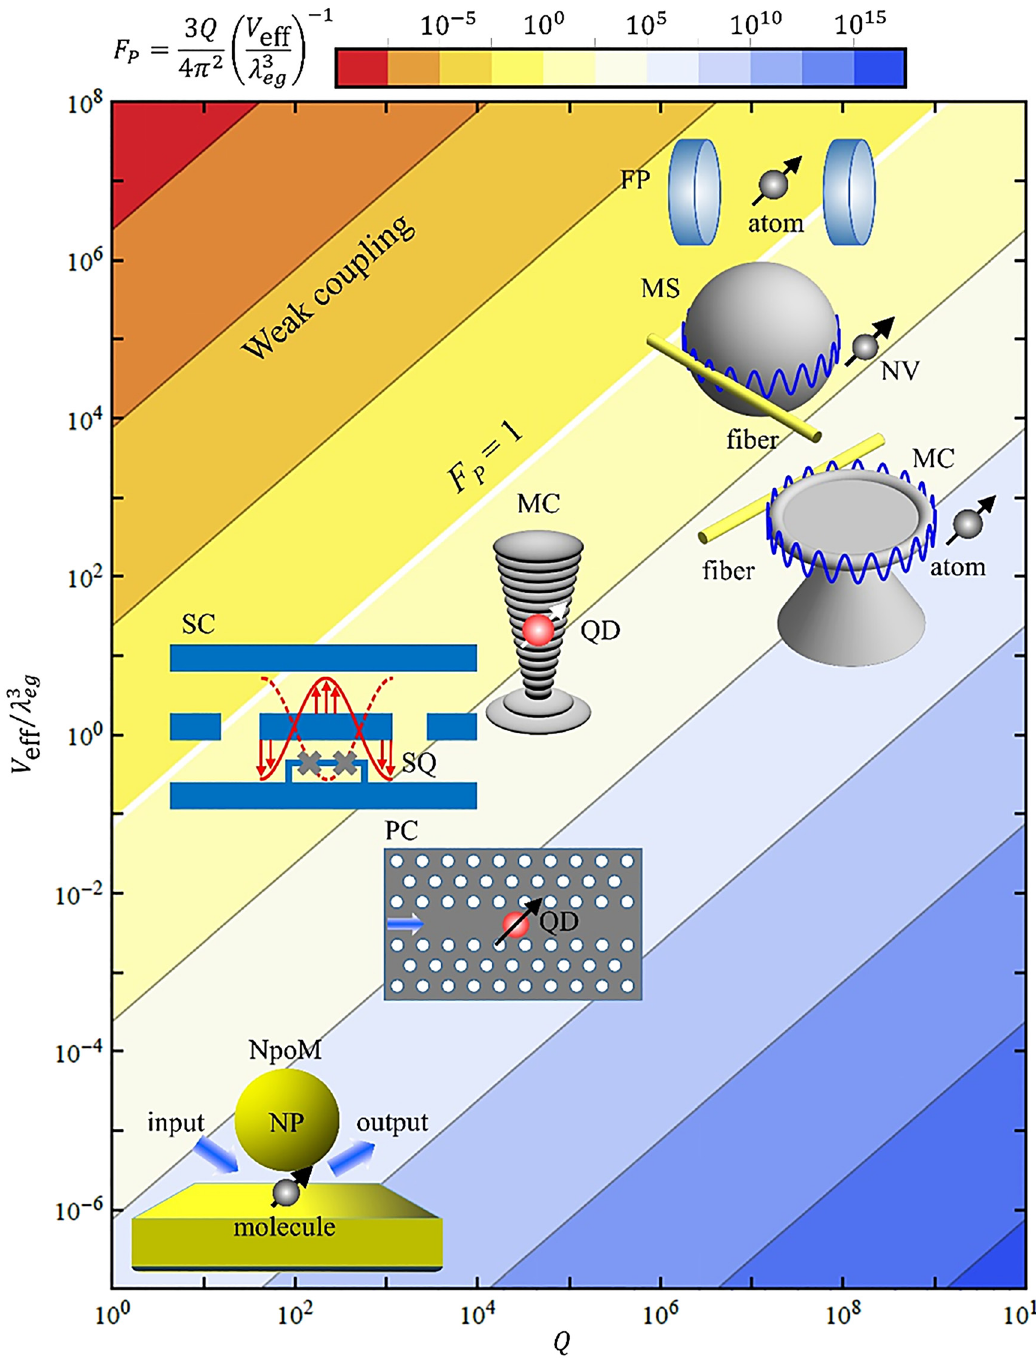
Figure 3: Purcell factors F P for different QED structures. The quantum emitters may be atoms, molecules, QD (quantum dot), NV (nitrogen-vacancy) centre and SQ (superconducting qubit). The resonators include FP (Fabry-Pérot), MT (microtoroid), MS (microsphere), MP (micropillar), PC (photonic crystal), NpoM (nanoparticle-on- mirror) and SC (superconducting) cavities. The arrow crossing sphere represents the transition dipole moment of the quantum emitter. All these QED systems achieved in experiment are in the strong-coupling regime F P >